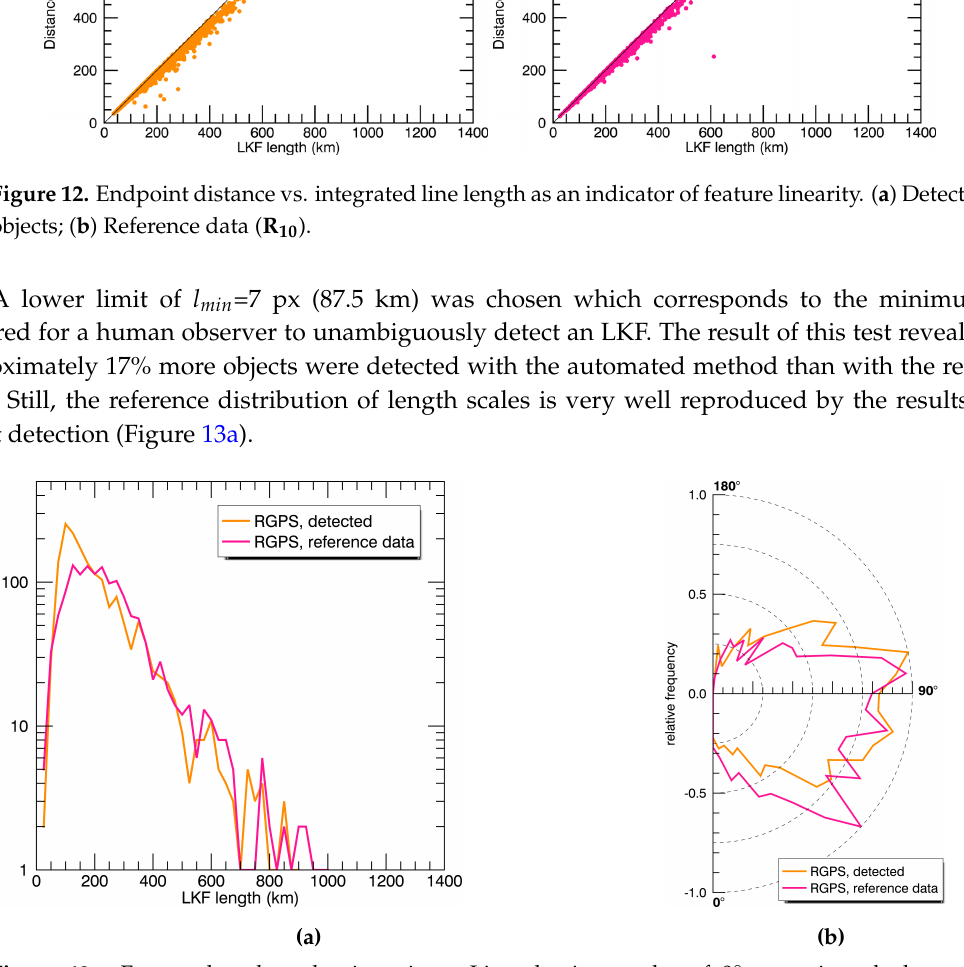
Figure 13. Feature length and orientation. Lines having angles of 0 ◦ are oriented along the parallels, lines with 90 ◦ angles are oriented in meridional direction. ( a ) Feature length distribution; ( b ) Distribution of feature orientation